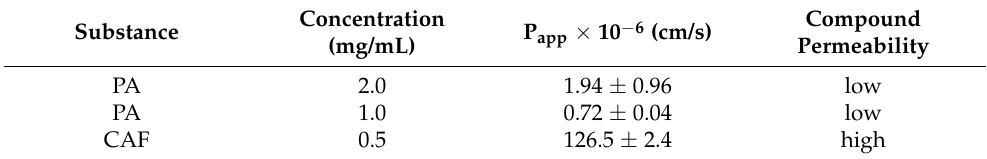
Figure 3. Kinetics curves of perindopril arginine (PA) ( A ) and caffeine (CAF) ( B ) transport across the Caco-2 monolayer. The experimentally ( ♦ ) and theoretically ( ······ ) determined “cumulative fraction transported” of the compounds versus time transport. PA transport was analyzed at the initial concentrations of 2.0 mg/mL and 1.0 mg/mL. The initial concentration of CAF was established at 0.5 mg/mL. Table 1. Apparent permeability coefficients (P app ) of perindopril arginine (PA) and caffeine (CAF) measured through Caco-2 monolayer. Results are reported as an average and standard deviation ( n = 3).